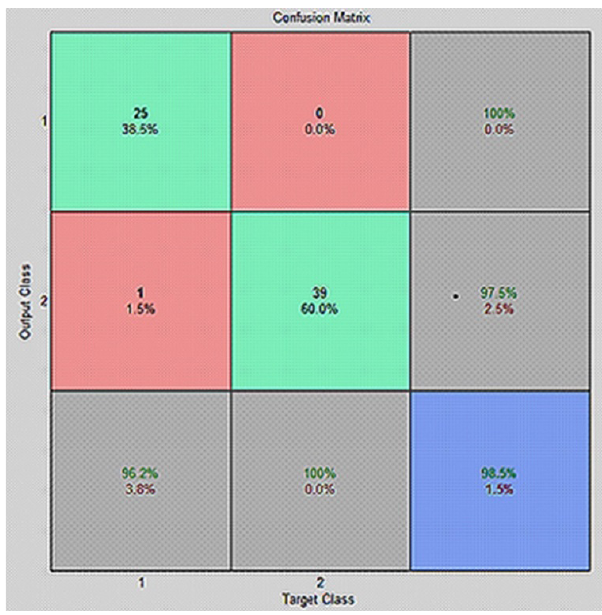
Fig. 10. Confusion matrix — M-RVM classi¯cation.